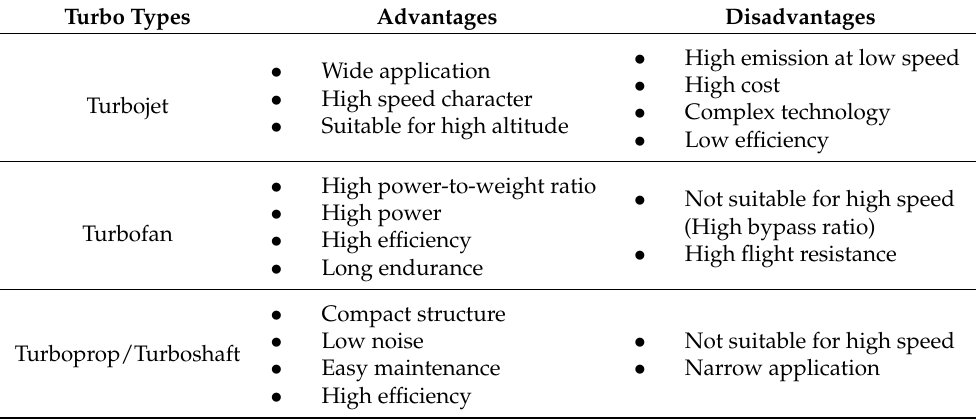
Table 3. Advantages and disadvantages of the four types of turbos.